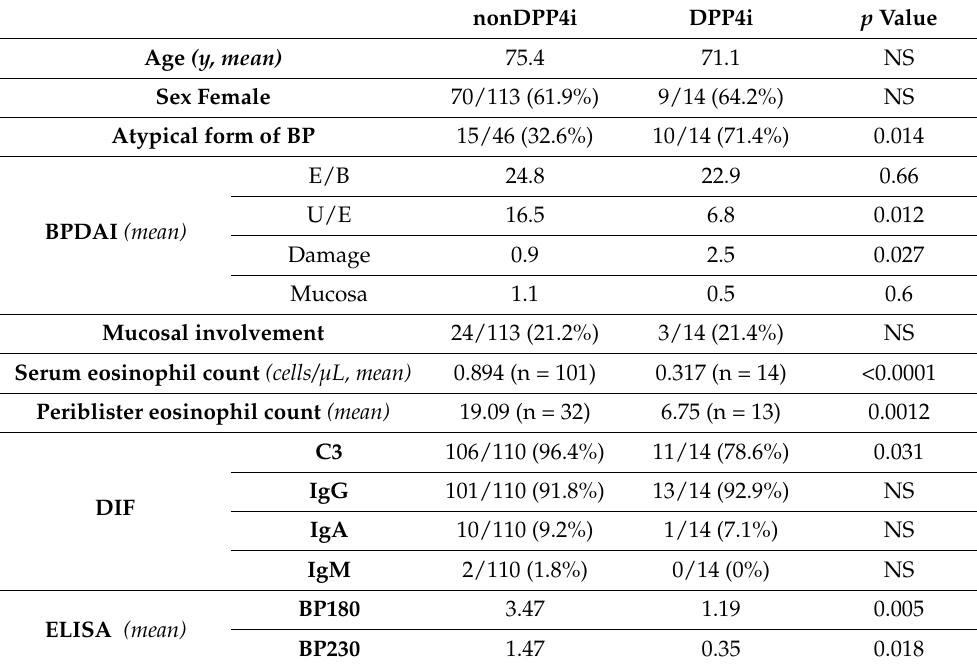
Table 1. Comparison of clinical, laboratory and histological findings in DPP4i-related and nonDPP4i BP